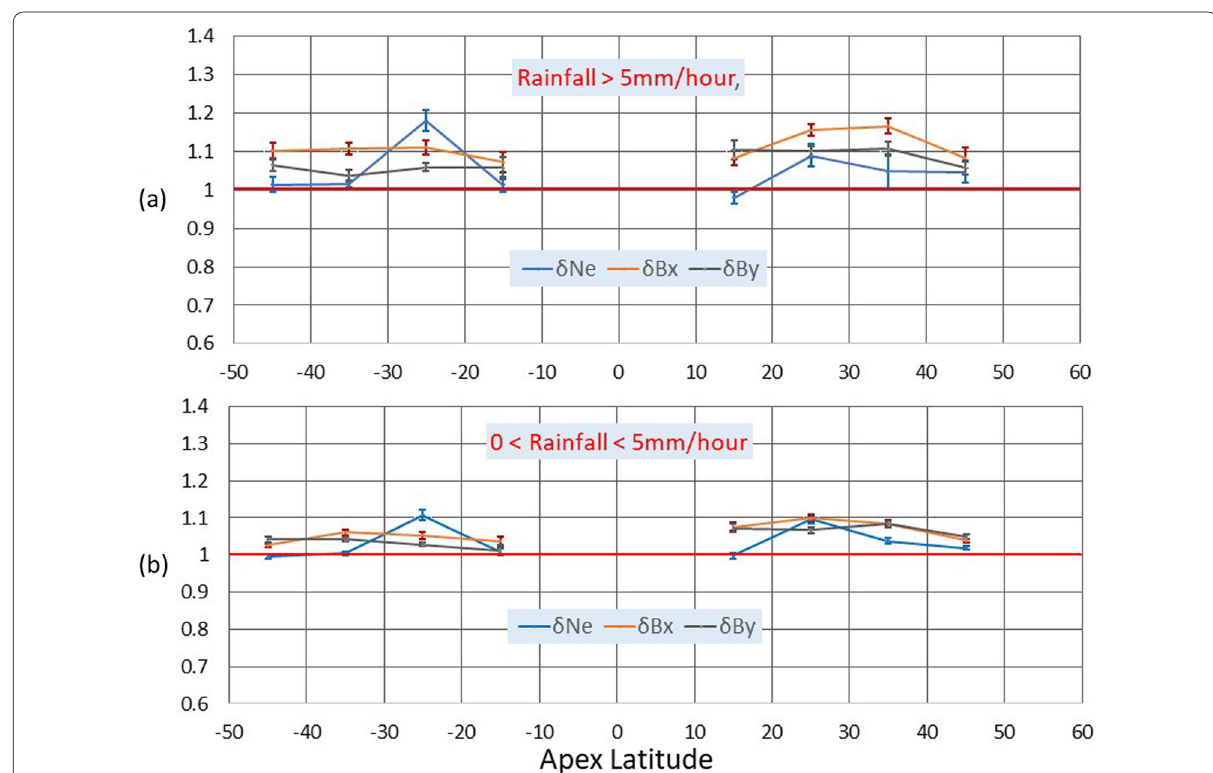
Fig. 9 Longitudinally averaged amplitude of each component in a heavy rain cases (> 5 mm/h), and b in weak rain (< 5 mm/h). The GSMaP data at the footprints traced to 120 km altitude, i.e., P1 and P2 in Fig. 1, are used. The blank area within force cannot reach satellite altitudes in this